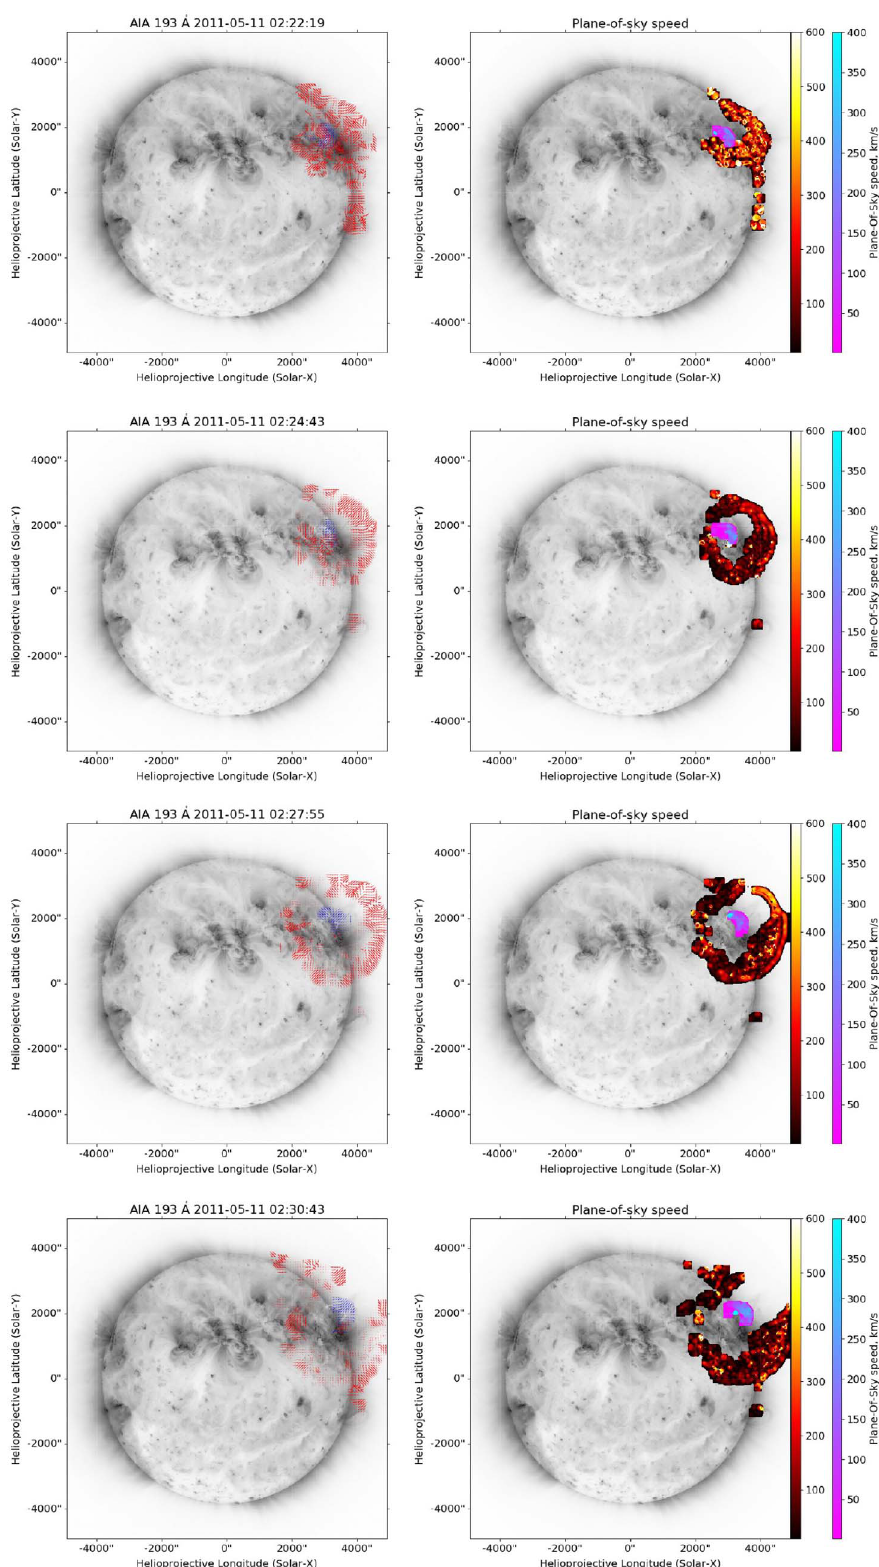
Fig. 13. The output of the FLCT models for the combined CBF/ fi lament May 11, 2011 event, for the three images is shown in Figure 5. Left panels: Arrows showing the plane-of-sky velocity vectors (red color for the CBF object, blue for the fi lament). Right panels: The plane-of-sky